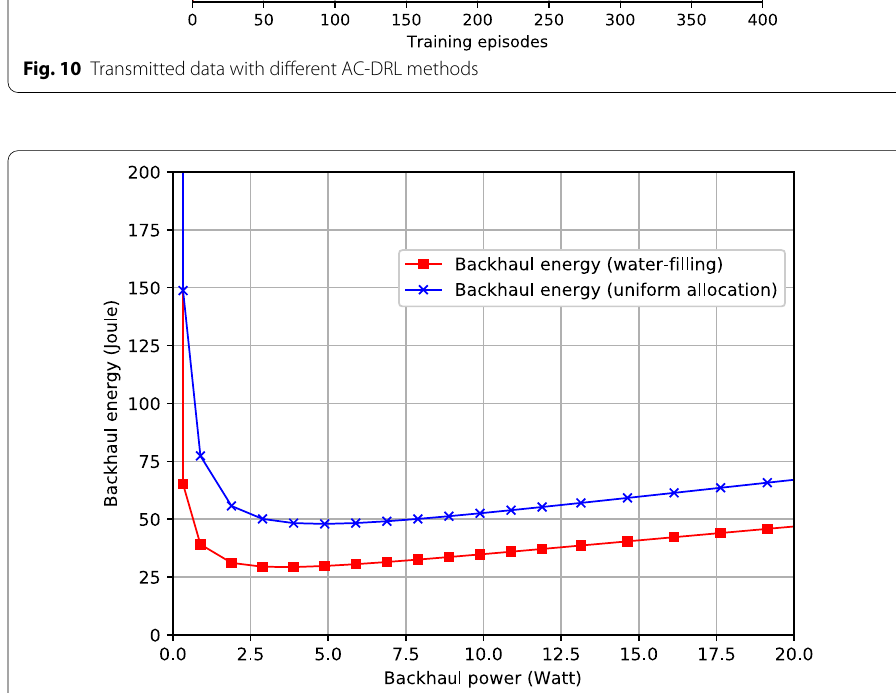
Fig. 11 Backhaul energy vs. backhaul